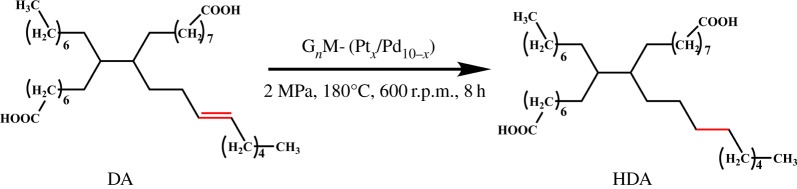
The hydrogenation of DA catalyzed by GnM-(Ptx/Pd10−x).